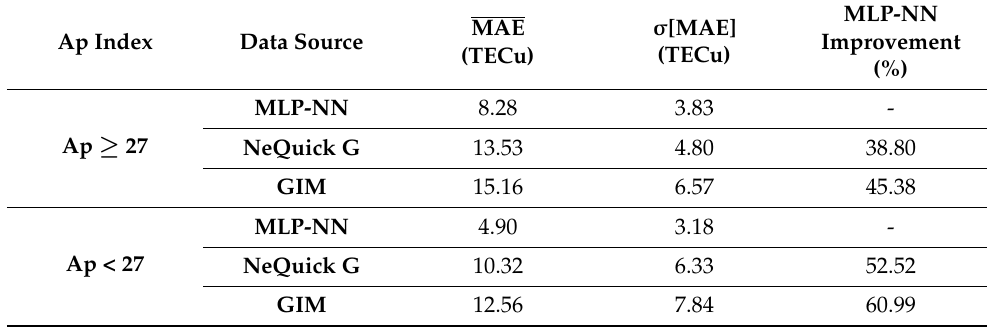
Table 3. MAE values for different TEC methods considering geomagnetic quiet and disturbed